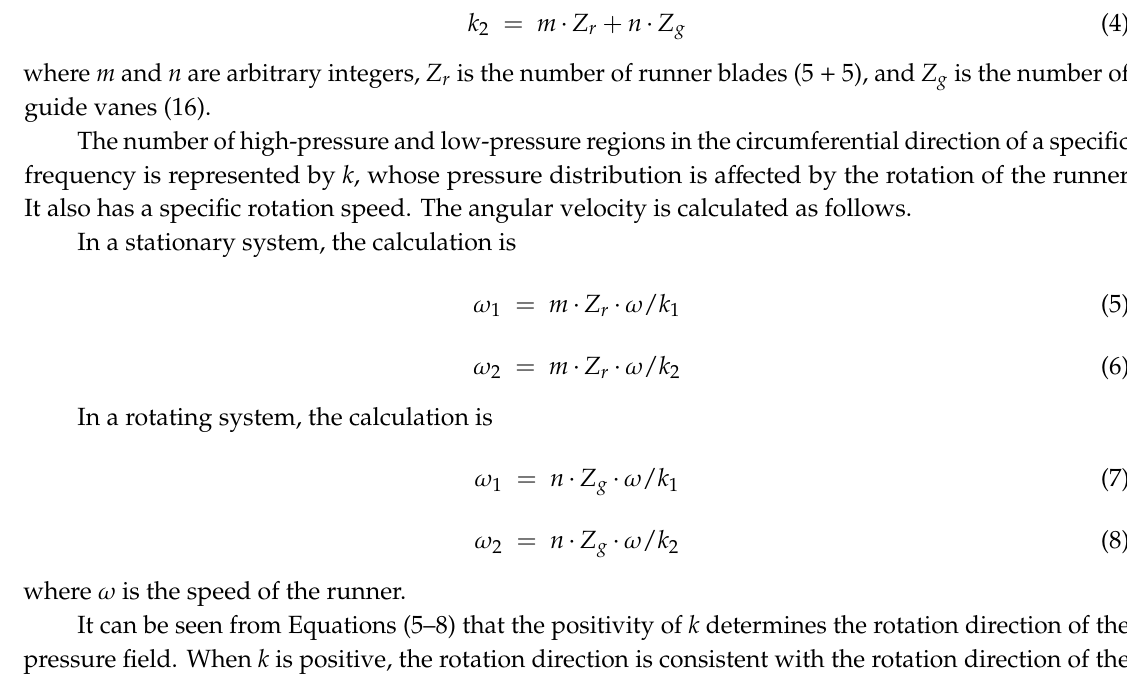
Figure 7. Monitoring points in the volute.